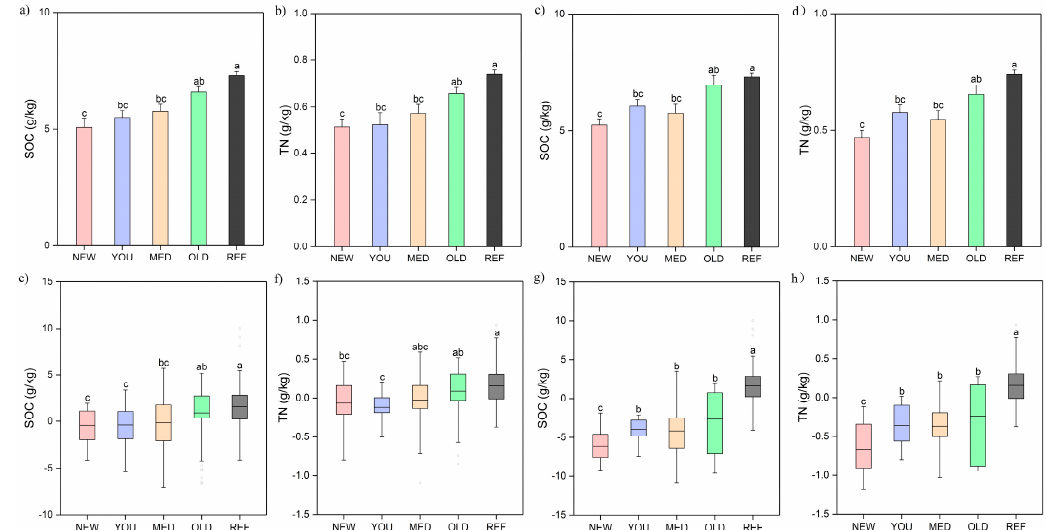
Figure 5. Impact of reclamation ages on soil C and N: ( a ) Soil organic carbon content in 2015 assarted from grassland, ( b ) Total nitrogen content in 2015 assarted from grassland, ( c ) Soil organic carbon content in 2015 assarted from forest, ( d ) Total nitrogen content in 2015 assarted from forest, ( e ) Change of soil organic carbon content assarted from grassland, ( f ) Change of total nitrogen content assarted from grassland, ( g ) Change of soil organic carbon content assarted from forest, ( h ) Change of total nitrogen content assarted from forest. NEW = newly assarted (1–5 years), YOU = young assarted (6–15 years), MED = medium assarted (16–25 years), OLD = old assarted (26–37 years), REF = referenced cropland assarted before 1978.